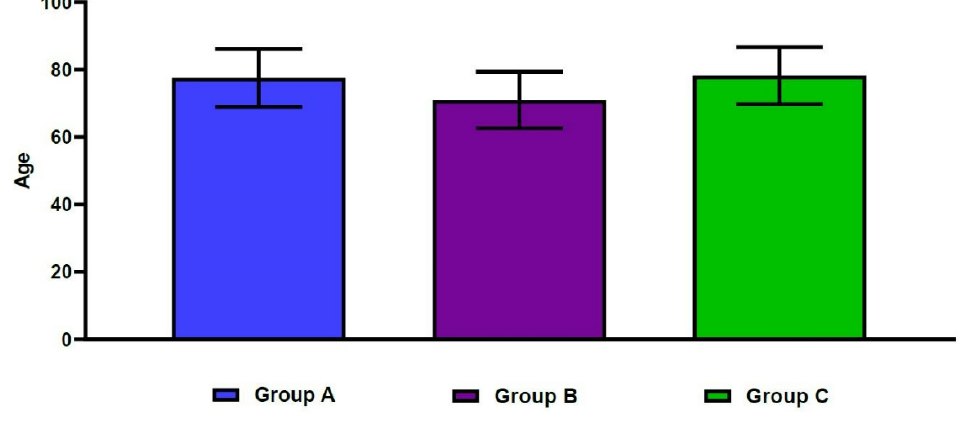
Figure 4. Differences in age between the three groups.